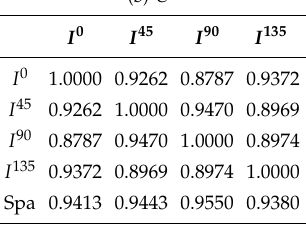
Table 2. Inter-channel correlation between the four polarization channels according to the spectral band. Last line of each subtable is the spatial correlation within each channel. Values are averaged over the ten multispectral images from [31]. Last subtable is the average over the six spectral channels. (a) C